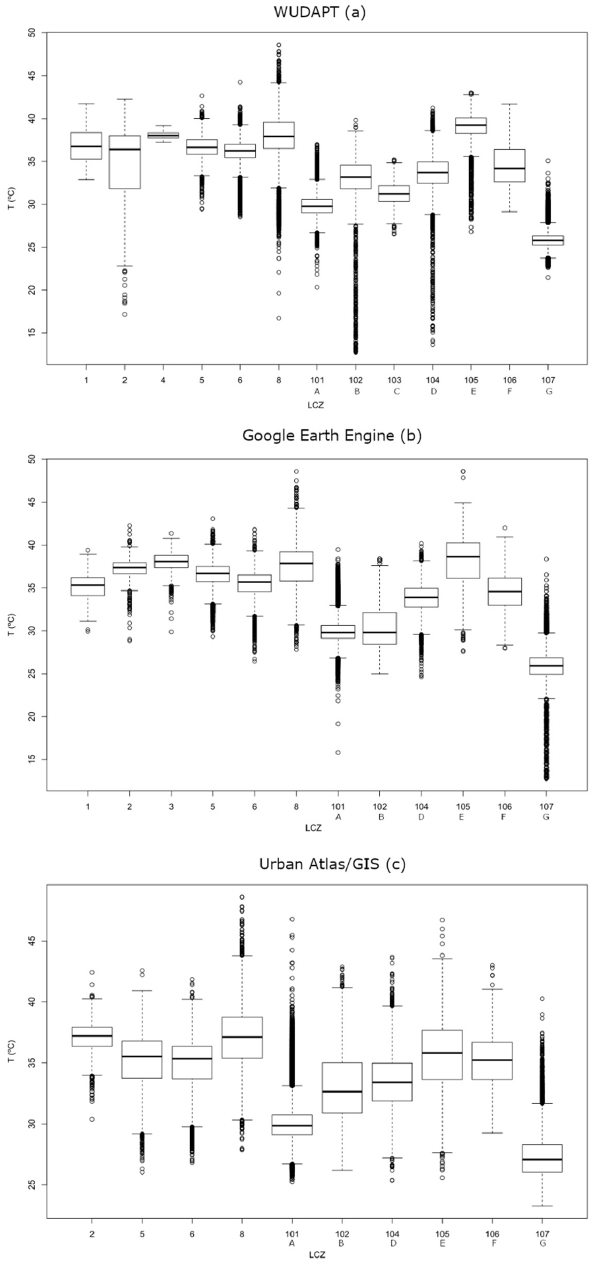
Figure 14. ( a – c ) LCZ temperature distribution, 30 July 2018, WUDAPT method ( a ), GEE method ( b ), UA method ( c ). Temperature Distribution According to the WUDAPT, Google Earth Engine, and Urban Atlas Methods The box/whisker plot, as shown in Figure 14 shows the ranges of the temperatures within each LCZ during the heat episode. The ‘boxes’ indicate the first (Q1) and third (Q3)